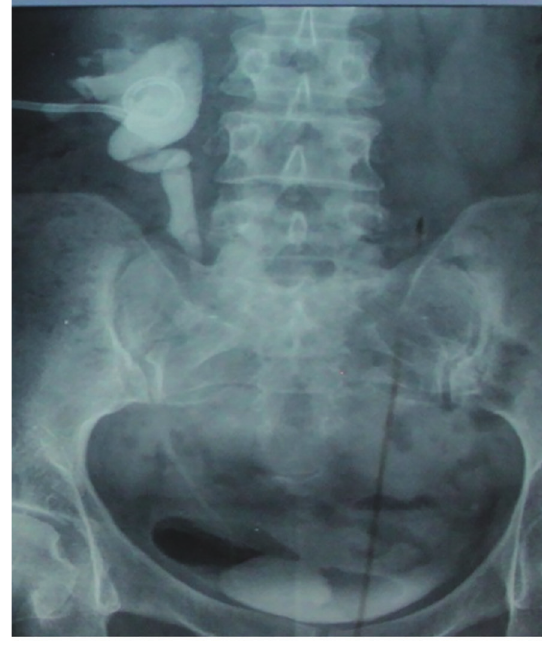
Figure 1 - Antegrade urography: long right ureteral stricture